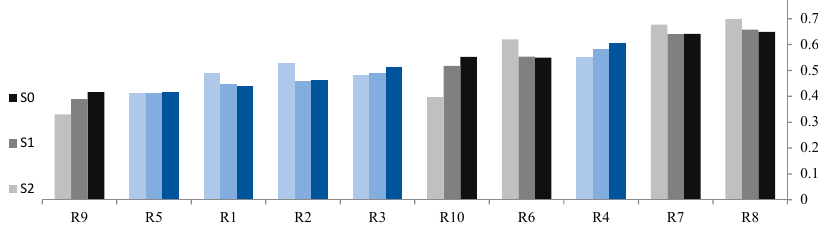
Figure 9. Ranking of risks at construction and exploitation phase in 5 investment